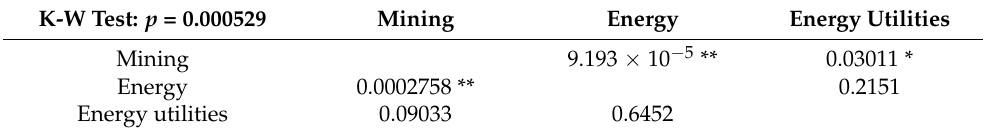
Table 3. Statistical significance of differences in total social grades, Bonferroni corrected \ incorrected.